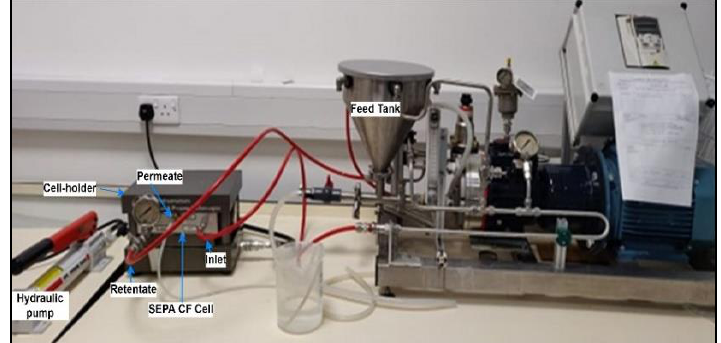
Figure 2. Laboratory setup of crossflow filtration.